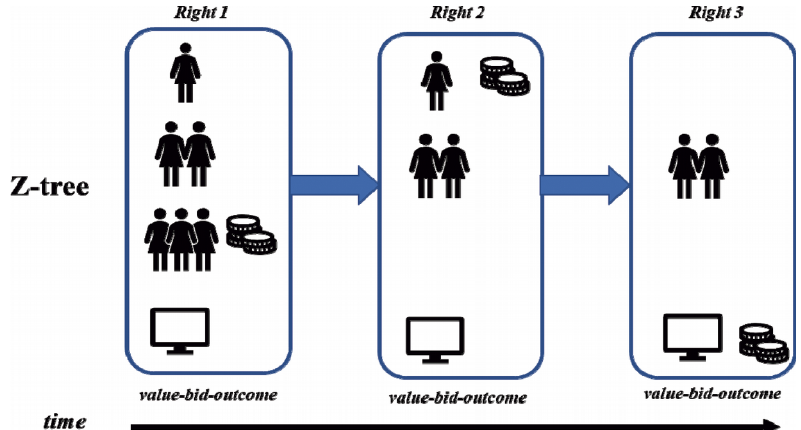
Figure 2. A representation of the business game: a sequential auction in which participants might be individuals or groups of different sizes. Rational machines could also be included as